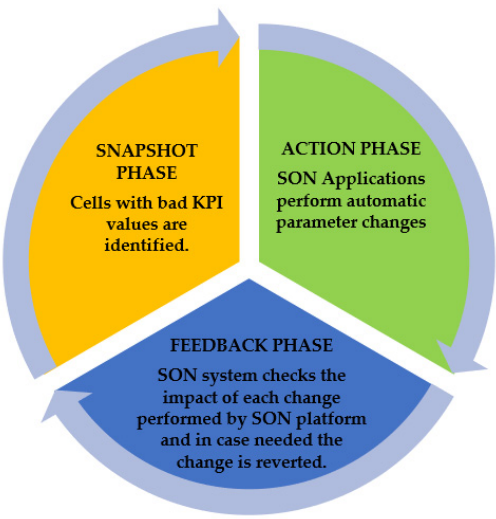
Figure 5. SON loop, basic phases, and lifecycle.